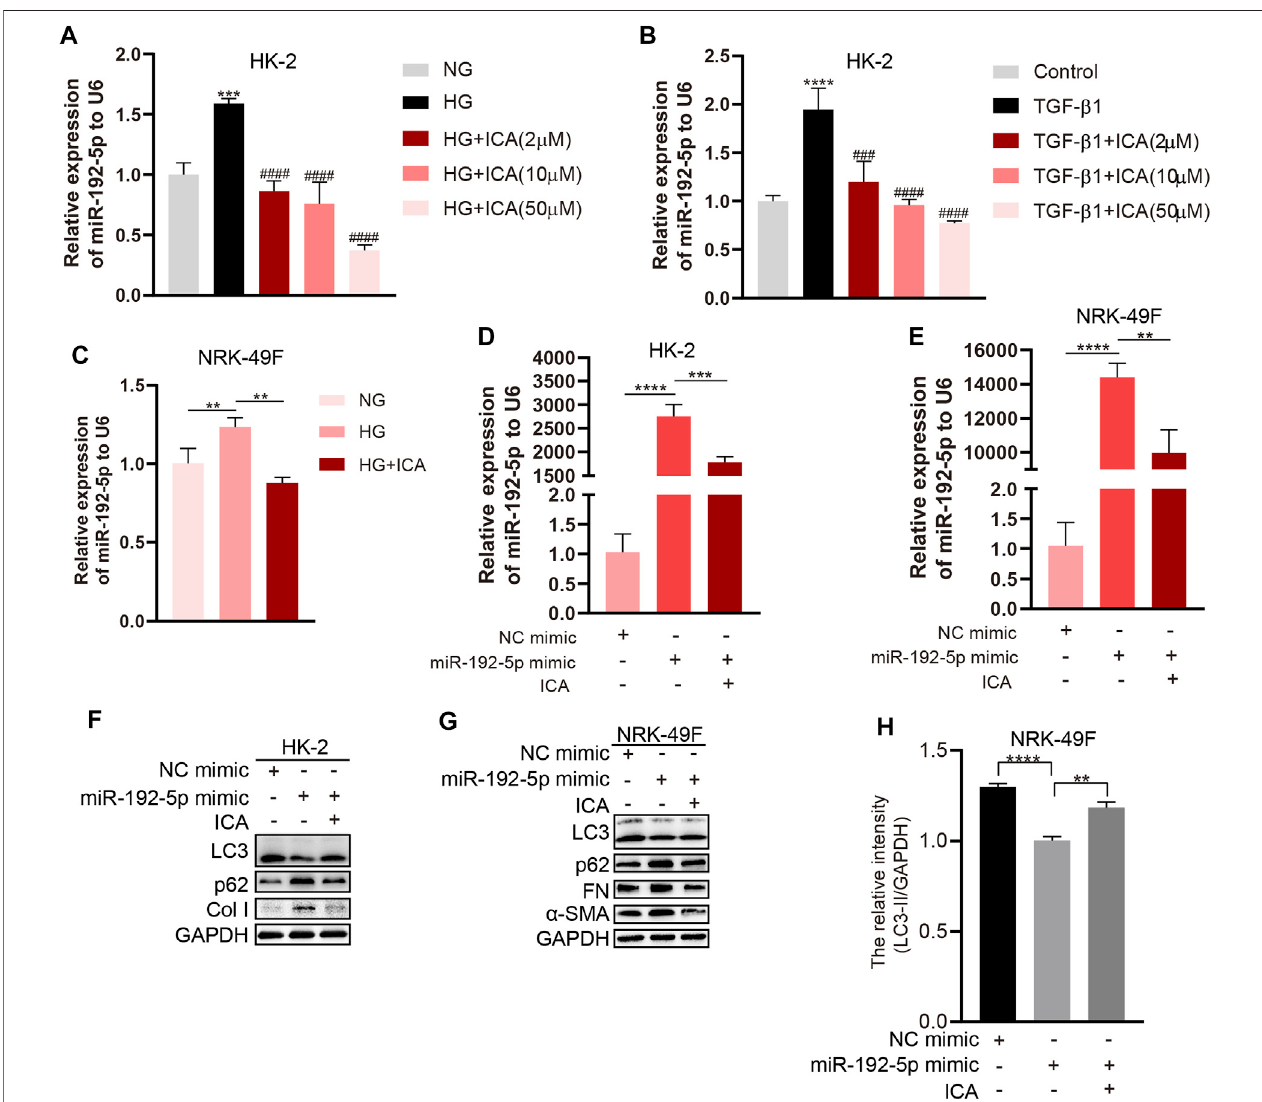
FIGURE 6 | ICA induces autophagy and reduces fi brosis by down-regulating miR-192-5p expression (A – B) Relative expression of miR-192-5p in HK-2 cells treated with HG, TGF- β 1 and ICA. *** p < 0.001, **** p < 0.0001 vs NG, ### p < 0.001, #### p < 0.0001 vs HG (C) Relative expression of miR-192-5p in NRK-49F cells treated with HG (30 mM) and ICA (2 μ M). ** p < 0.01 (D – E) Relative expression of miR-192-5p in HK-2 and NRK-49F cells transfected with miR-192-5p mimic and treatedwithICA(2 μ M).** p < 0.01,*** p < 0.001,**** p < 0.0001 (F – G) TheexpressionofLC3,p62, α -SMA,ColIandFNinHK-2andNRK-49Fcellstransfectedwith miR-192-5p mimic and treated with ICA (2 μ M) (H) The relative intensity of LC3-II in NRK-49F cells was analyzed by the ChemiScope analysis software, ** p < 0.01, **** p < 0.0001.